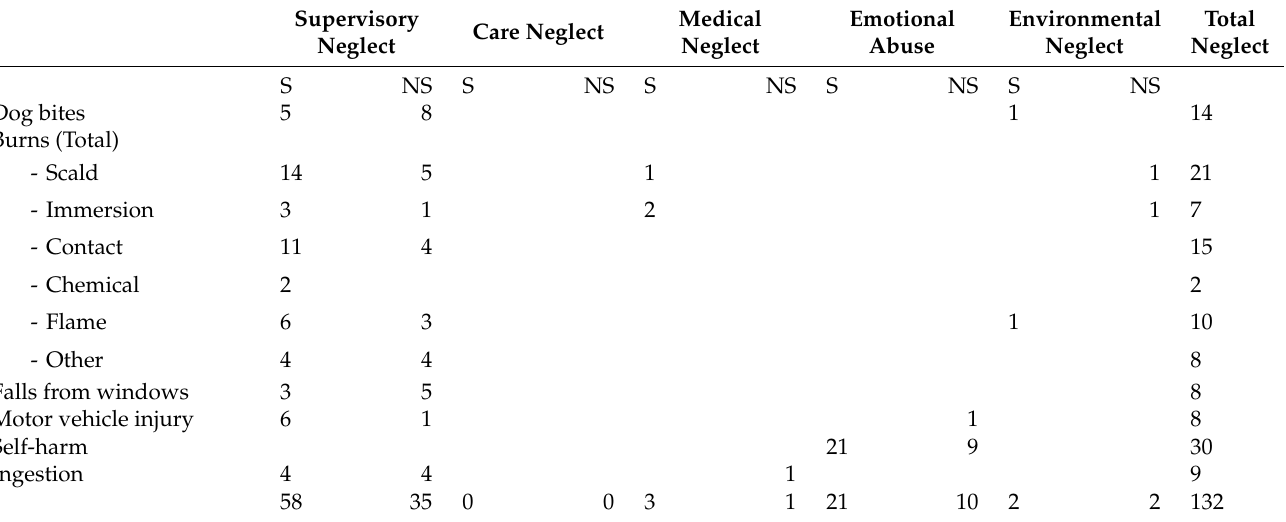
Table 4. Cases of neglect and emotional abuse associated with injury presentation.